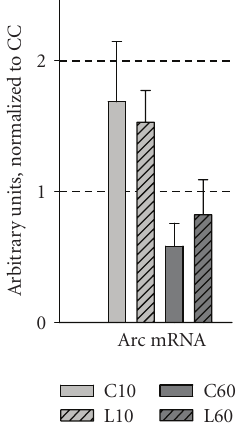
Figure 2: Expression levels of Arc in the dentate gyrus after object recognition. Fold change in mRNA levels (relative to the CC group) is presented for Arc in the dentate gyrus of animals from all five groups ( n = 8 for all groups, except L60, n = 7). Data are presented as mean ± SEM. Gene expression was normalized to control genes (see